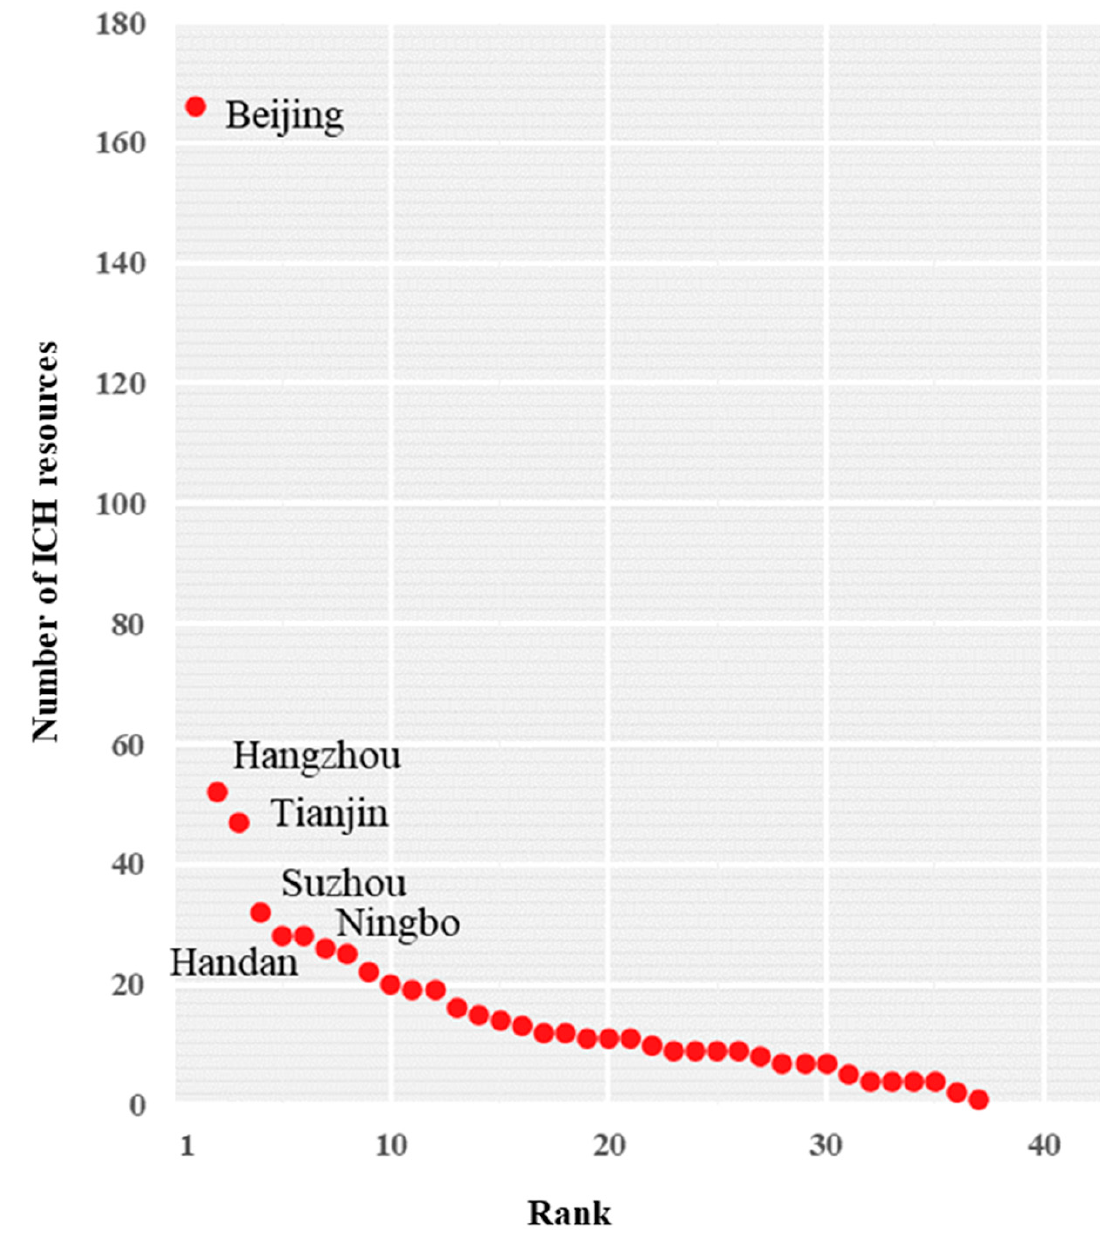
Figure 4. Rank sequence for the number of intangible cultural heritage (ICH) resources. Second, the kernel density results in Figure 5 show the overall spatial aggregation distribution characteristics of ICH resources. The aggregation characteristics of ICH in Beijing and Hangzhou are apparent, which is consistent with the overall conclusion of the quantitative distribution characteristics in those administrative regions. However, there was no obvious gathering phenomenon in Tianjin and other cities even though the numbers of ICH resources in these cities were high, as shown in Figure 3. Conversely, the ICH resources in Suzhou and Yangzhou were clustered along the Grand Canal, having greater reference values for the regeneration and utilization of the Grand Canal and ICH resources and benefitting from the geospatial